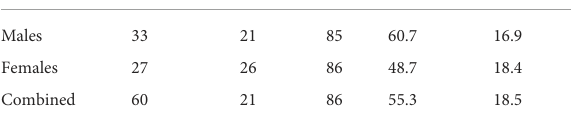
TABLE 1 Age at diagnosis of renal cell